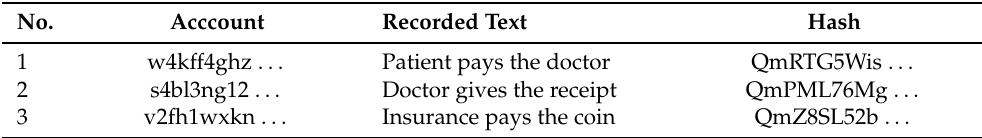
Table 2. Table 3. Recorded activities in transaction